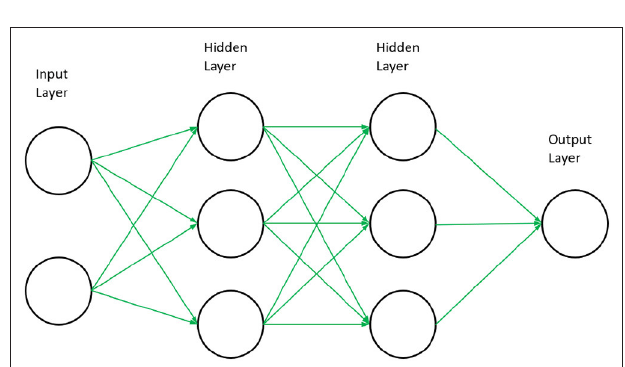
FIGURE 7 | Schematic of a feed forward neural network. Arrows represent the weight values that are optimized during the training of a neural network model and circles represent the